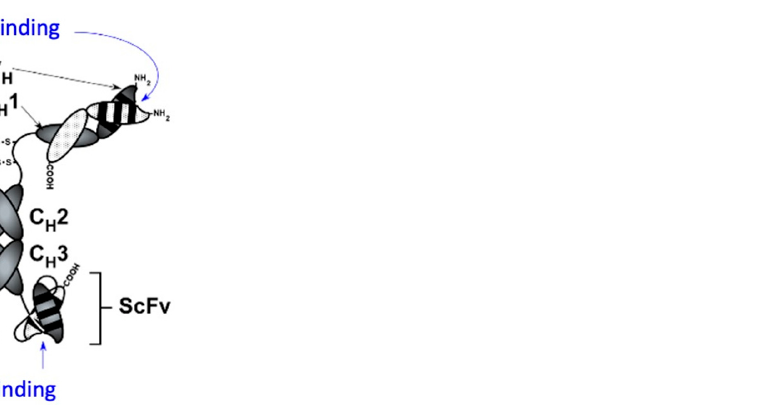
Figure 7. Schematic representation of a tetravalent bispecific MAb. In this construct, the transport domain of the fusion protein targets the BBB human insulin receptor (HIR), and the therapeutic domain is a single-chain anti-A β antibody monomer (ScFv) fused to the carboxyl terminus of the heavy chain of the HIRMAb. This tetravalent bispecific Mab maintains a high affinity for both A β and the BBB insulin receptor [29].